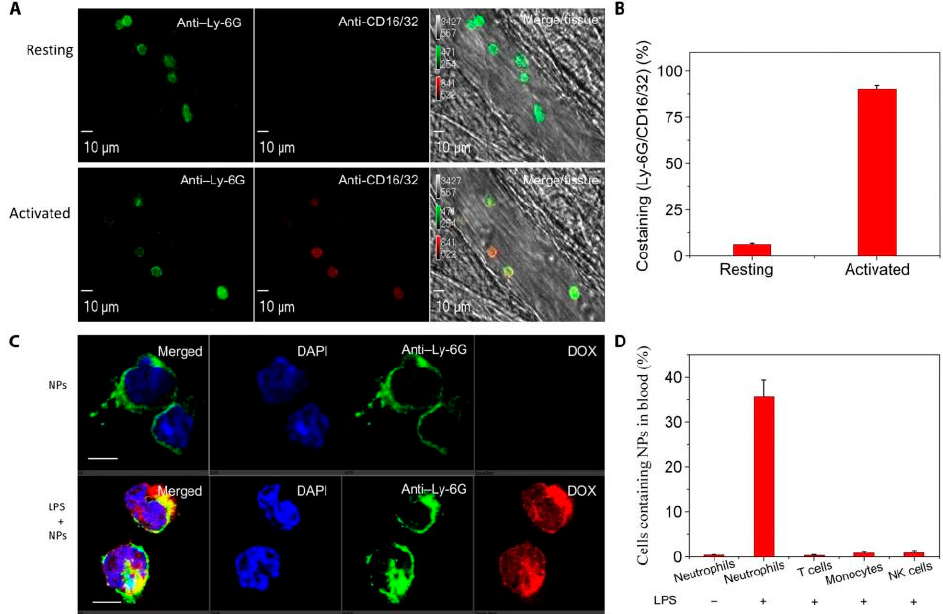
Figure 2. In situ nanoparticle targeting to activated neutrophils via Fc γ receptors. ( A ) Intravital microscopy of mouse cremaster muscle venules shows that neutrophil activation up-regulates Fc γ receptors. The resting neutrophils was established by no intrascrotal injection of TNF-a (0.5 mg per mouse) and the tail vein injection of Fc γ antibodies 3 h before performing intravital microscopy (top). Intrascrotal injection of TNF-a (0.5 mg per mouse) activated neutrophils. Alexa Fluor 647-labeled anti-mouse CD16 / 32 (red) and Alexa Fluor 488-labeled anti-mouse LY-6G (green) antibodies were intravenously injected to stain Fc γ receptors and neutrophils, respectively (bottom). Scale bars, 10 mm. ( B ) Percentages of co-staining between anti-mouse CD16 / 32 and anti-mouse LY-6G based on intravital images of ( A ). ( C ) Confocal laser scanning microscopy (CLSM) images of blood neutrophils from healthy mice or lipopolysaccharide (LPS)-challenged mice. Four hours after intraperitoneal LPS injection, doxorubicin conjugated bovine serum albumin nanoparticle (DOX-hyd-BSA) NPs were intravenously administered to a mouse. 3 h later, the mouse blood was collected, and neutrophils were isolated using anti-mouse LY-6G beads. Alexa Fluor 488-labeled antimouse LY- 6G antibody was used to label neutrophils. Scale bars, 10 mm. ( D ) Uptake of BSA NPs by blood leukocytes analyzed by flow cytometry. Neutrophils, T cells, monocytes, and natural killer (NK) cells were isolated from blood and stained by Alexa Fluor 647-labeled anti-mouse LY-6G, CD3, CD115, and CD335 antibodies, respectively. All data are expressed as means ± SD (three mice per group). (Reproduced from [105]; Published by American Association for the Advancement of Science (AAAS),